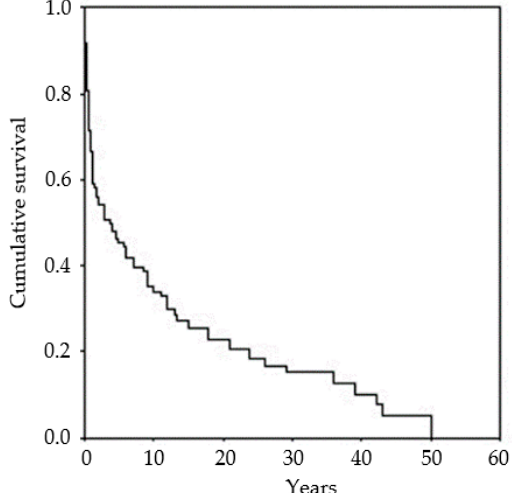
Figure 1. Kaplan–Meier survival curve. Overall survival was 11.5 years (mean, 95% Confidence Limits 8.5–14.5).